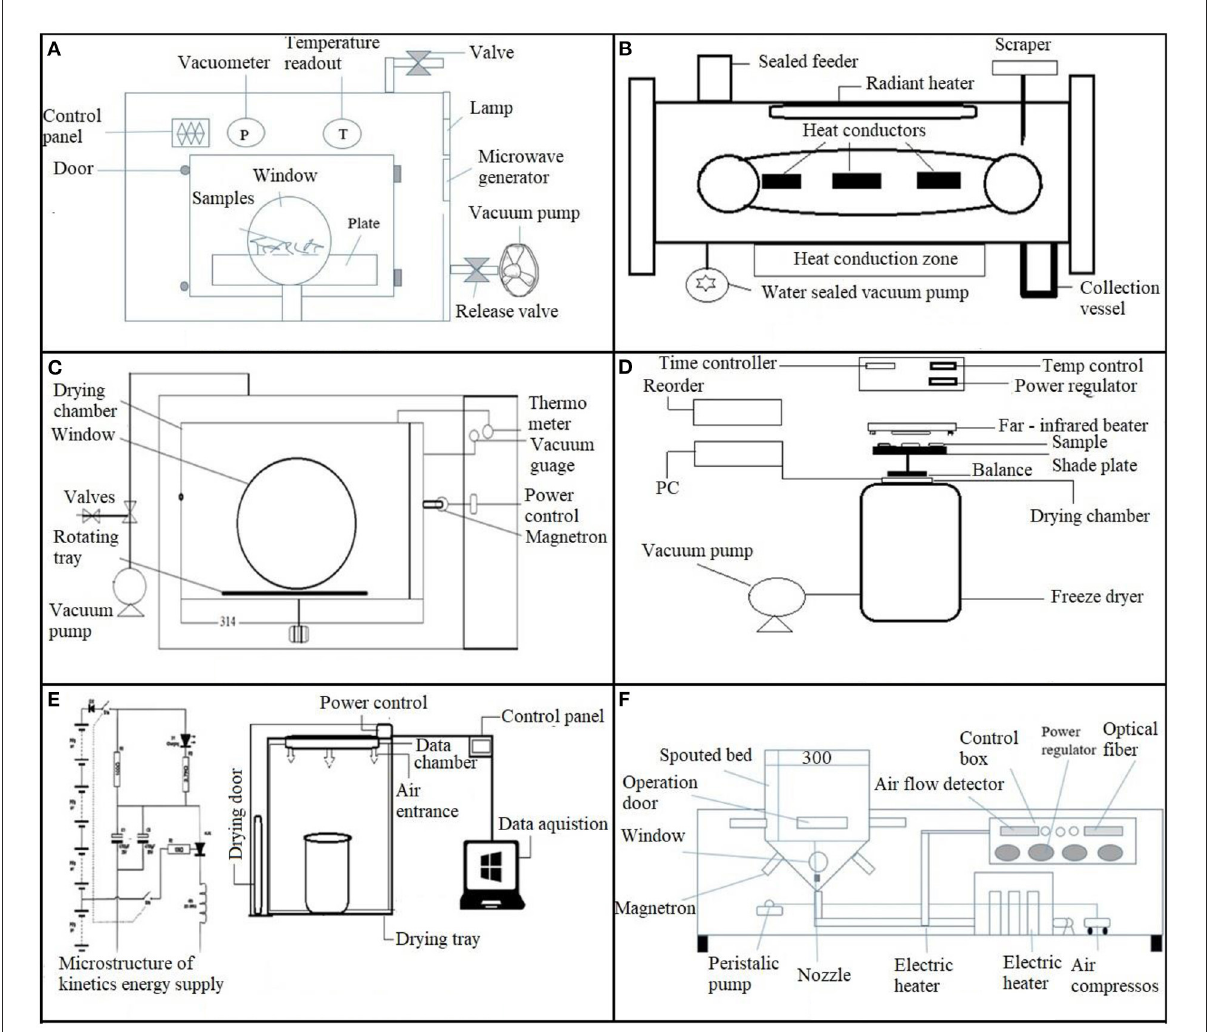
FIGURE5 Special purpose drying techniques are used for sweet potatoes. (A) Vacuum microwave dryer. (B) Continuous vacuum belt dryer. (C) Microwave vacuum dryer. (D) Freeze dryer and far-infrared dryer. (E) Combined hot air and infrared dryer. (F) Microwave spouted bed